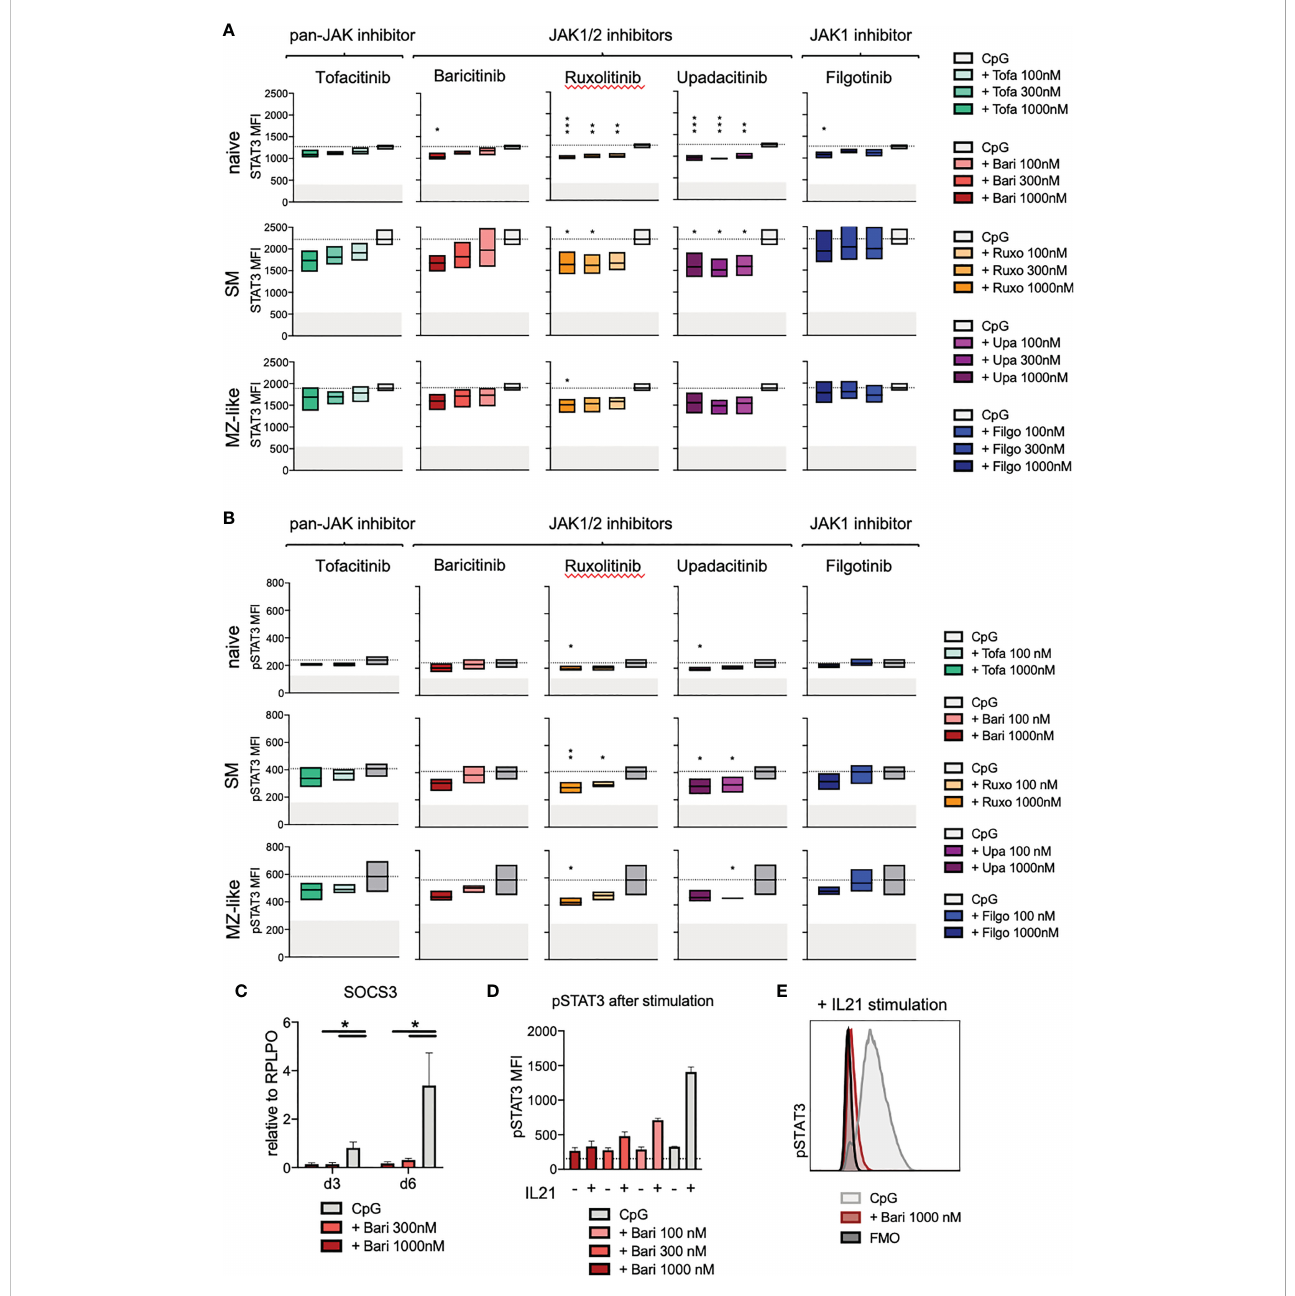
FIGURE 5 STAT3 expression and phosphorylation under JAK inhibitor treatment. Primary total B cells stimulated with CpG on day 0 and treated with scalar doses of JAK inhibitors as indicated, intracellular staining performed on day 3 of culture. (A) : STAT3 expression in CD19+ B cells analyzed by fl ow cytometry. Data of 3 independent experiments, depicted as fl oating bars (min to max) of STAT3 mean fl uorescence intensity. ANOVA with Dunnett ’ s multiple comparisons test as follow-up test. *p < 0.05, **p < 0.005, ***p < 0.0005, indicate signi fi cant differences of JAK inhibitors compared to CpG control. (B) : Basal phosphorylation (without further stimulation) of STAT3 in CD19+ B cells, analyzed by fl ow cytometry. Data of 3 independent experiments, with duplicates depicted as fl oating bars (min to max) with line at mean. ANOVA with Dunnett ’ s multiple comparisons test as follow-up test, *p < 0.05, **p < 0.005 indicate signi fi cant differences of JAK inhibitors compared to CpG control. (C) : Expression of STAT3-target gene SOCS3 under baricitinib treatment assessed by qPCR. Data from 4 experiments depicted relative to B cell housekeeping gene RPLPO. ANOVA with Dunnett ’ s multiple comparisons test, *p < 0.05. (D, E) : STAT3 phosphorylation under baricitinib treatment upon additional stimulation of B cells with IL-21. IL-21 was added to indicated wells 15 minutes before fi xation of cells, otherwise as detailed